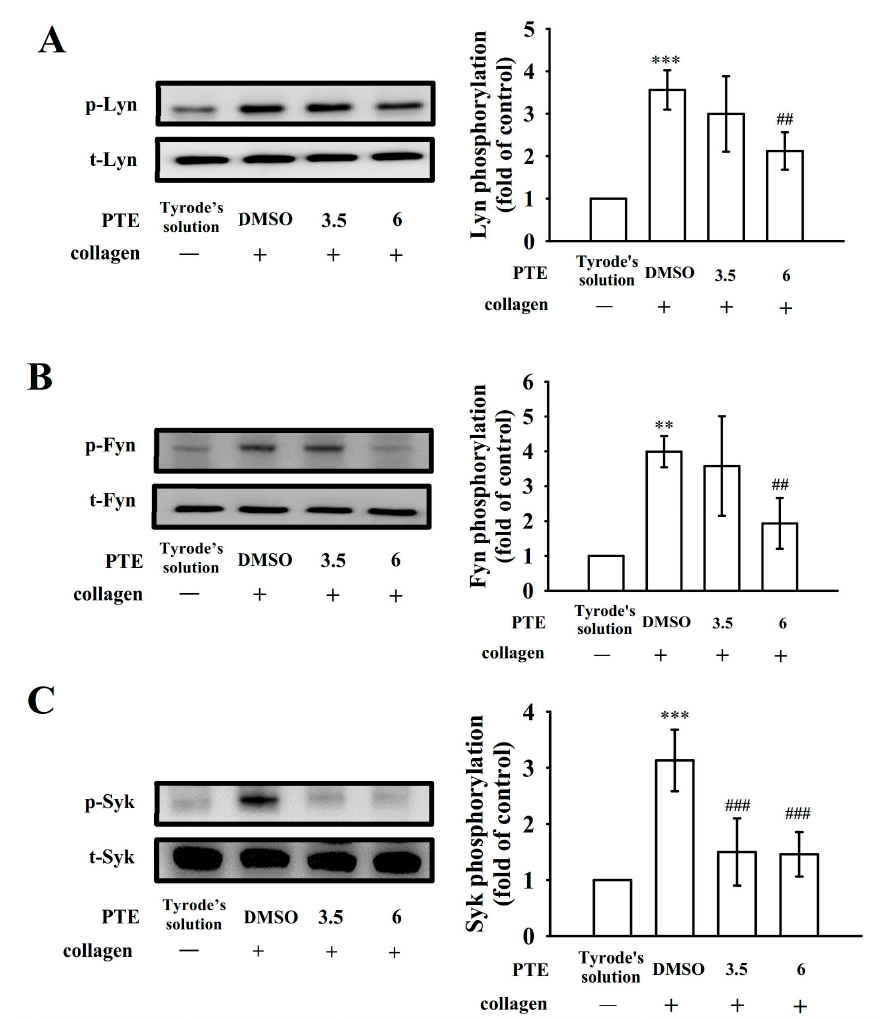
Figure 2. Effectiveness of pterostilbene (PTE) in Lyn, Fyn, and Syk activation in human platelets. Washed platelets (1.2 × 10 9 cells/mL) were preincubated with 0.1% DMSO or PTE (3.5 and 6 μ M), followed by the addition of collagen (1 μ g/mL) to trigger ( A ) Lyn, ( B ) Fyn, and ( C ) SyK phosphor- ylation. Platelets were collected, and subcellular extracts were examined to determine the levels of protein phosphorylation. Data are presented as the mean ± standard deviation ( n = 4). ** p < 0.01 and *** p < 0.001, compared with the resting control; ## p < 0.01 and ### p < 0.001, compared with the 0.1% DMSO-treated